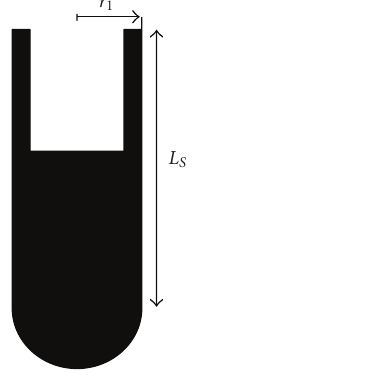
Figure 4: High pressure vessel with falling sinker viscometer